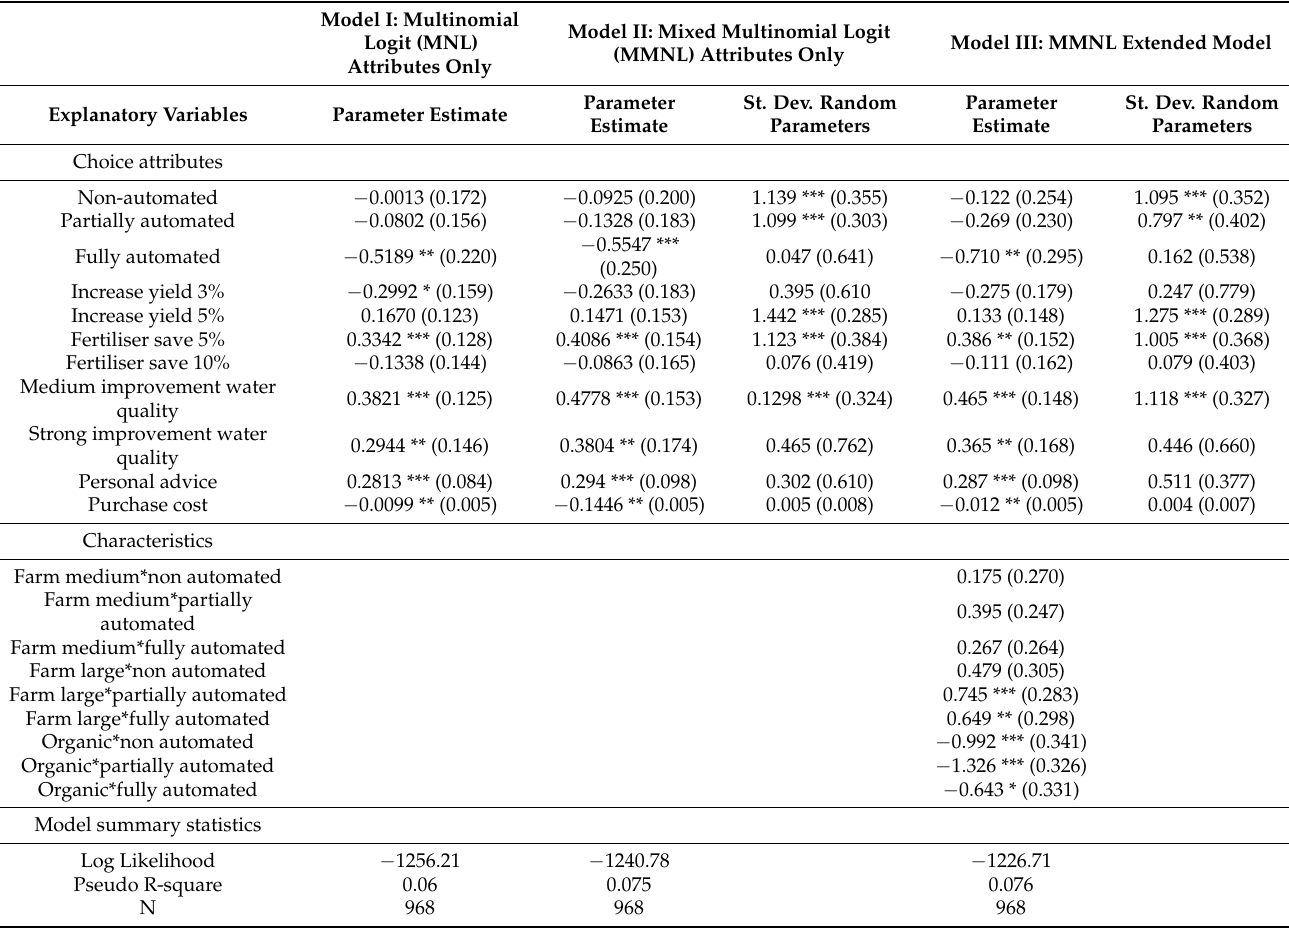
Table 4. Results of multinomial logit and mixed logit